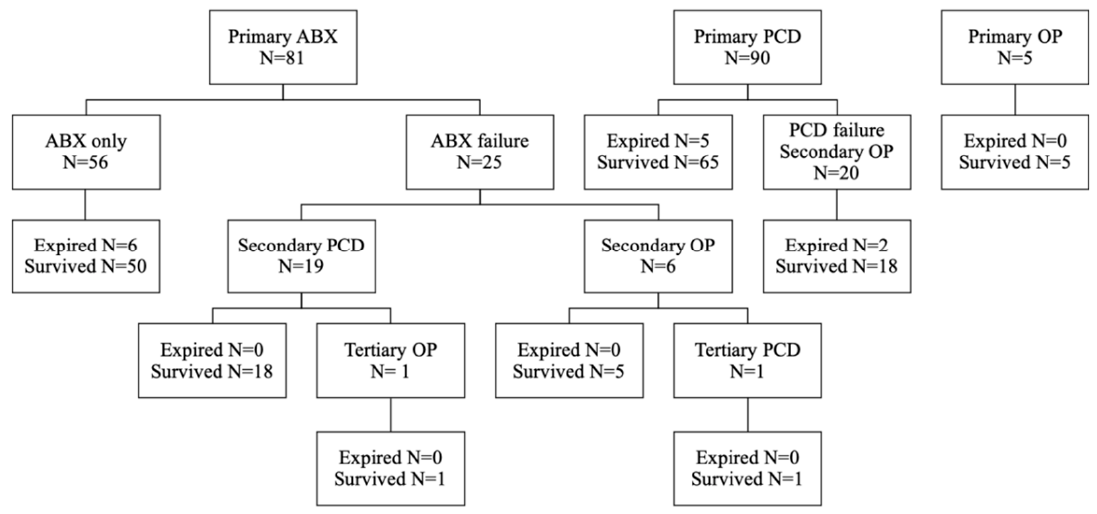
Figure 2. Treatment outcomes with primary antibiotics, percutaneous drainage, and operation in patients with iliopsoas abscess. ABX: antibiotics; PCD: percutaneous drainage; OP: operation.